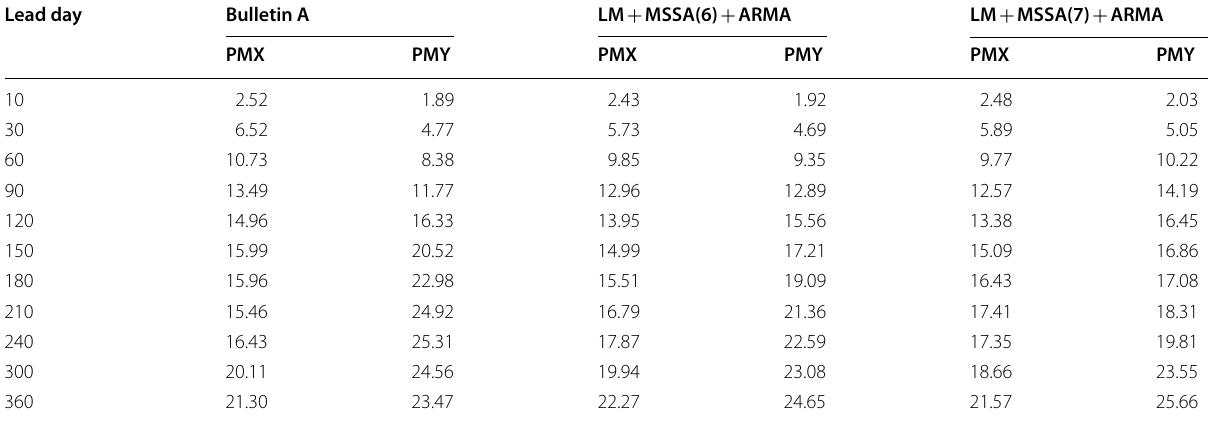
MSSA ARMA model + +